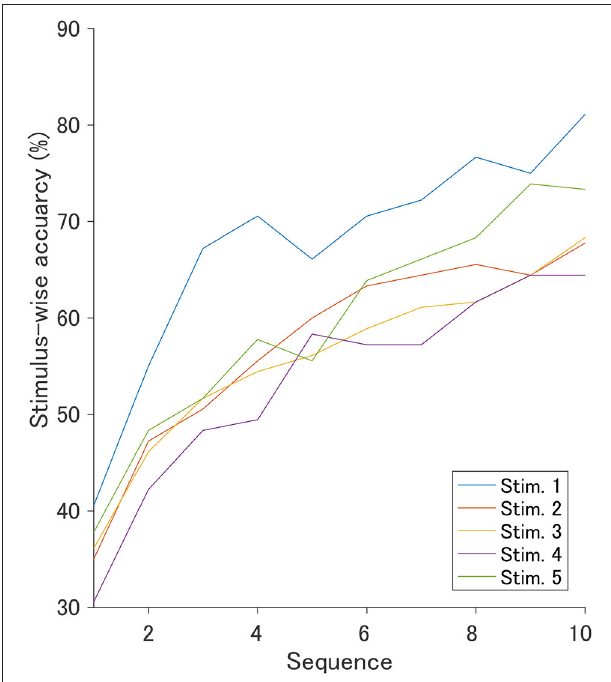
FIGURE 7 | Offline stimulus-wise classification accuracy in 1–10 sequences using a fixed